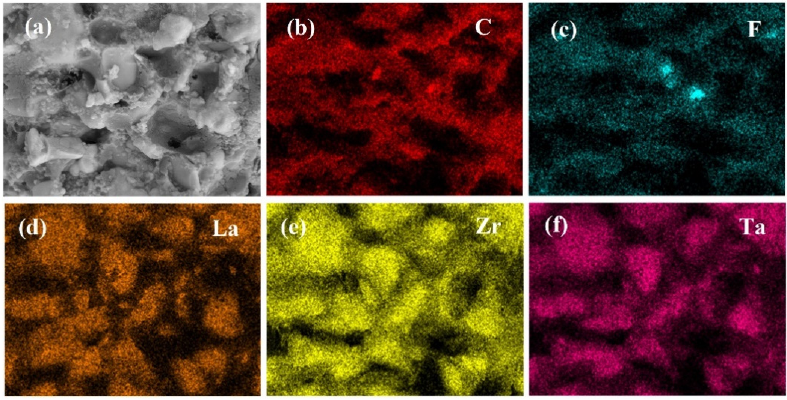
Figure 5. ( a ) SEM images and ( b – f ) EDS mapping results of the best performance cold-sintered LLZTO-PEO 2 -LiTFSI composite electrolyte.